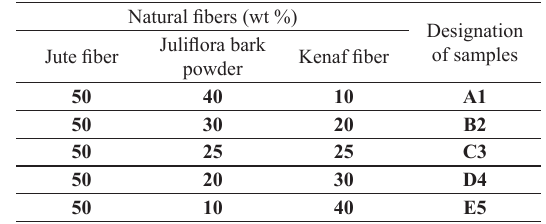
Table 2. Composition and designation of hybrid composite